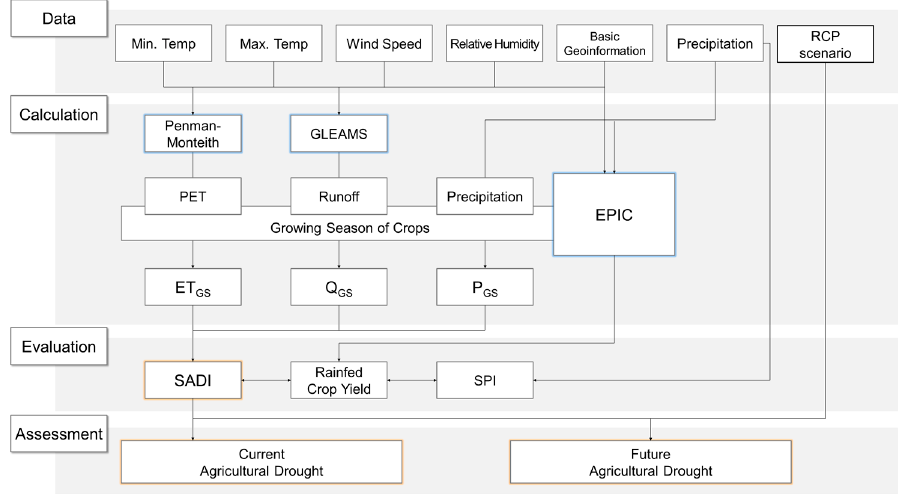
Figure 2. Graphical methodology of this study.